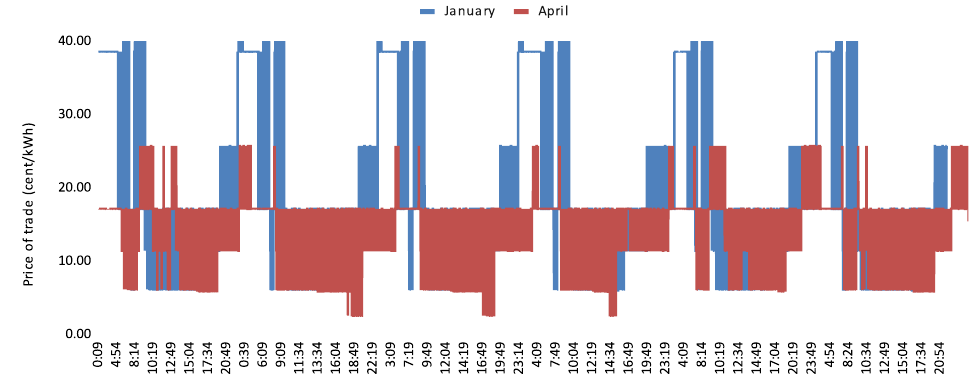
Figure 8. January and April trading prices compared.